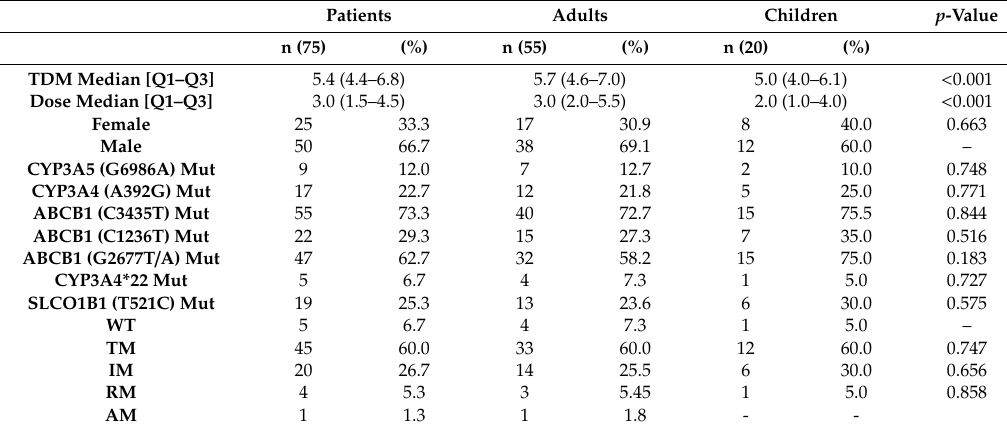
Table 1. Patient’s